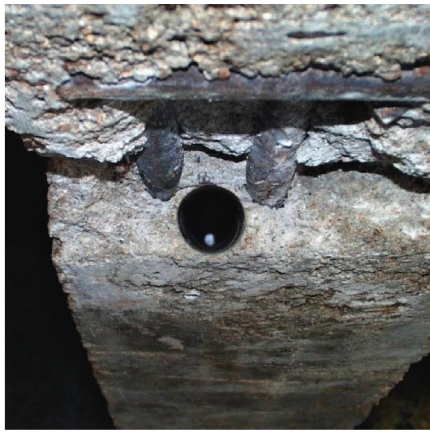
Figure 5: An example of a substitute cable duct ( ϕ 52mm) outlet at the bottom side of the beam in a suitable position in a gap between the existing